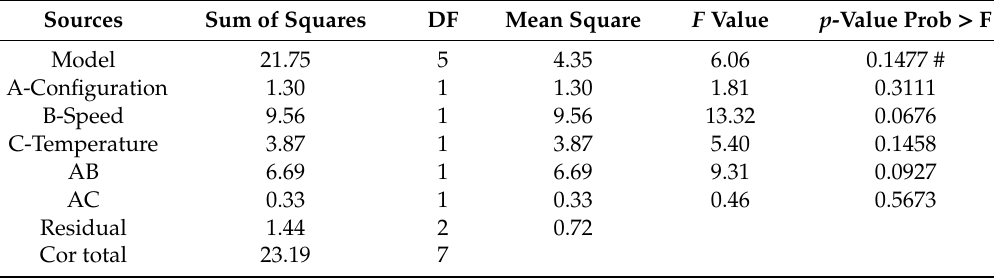
Table 3. One-way analysis of variance (ANOVA) table for drug content (Design Expert ® software).